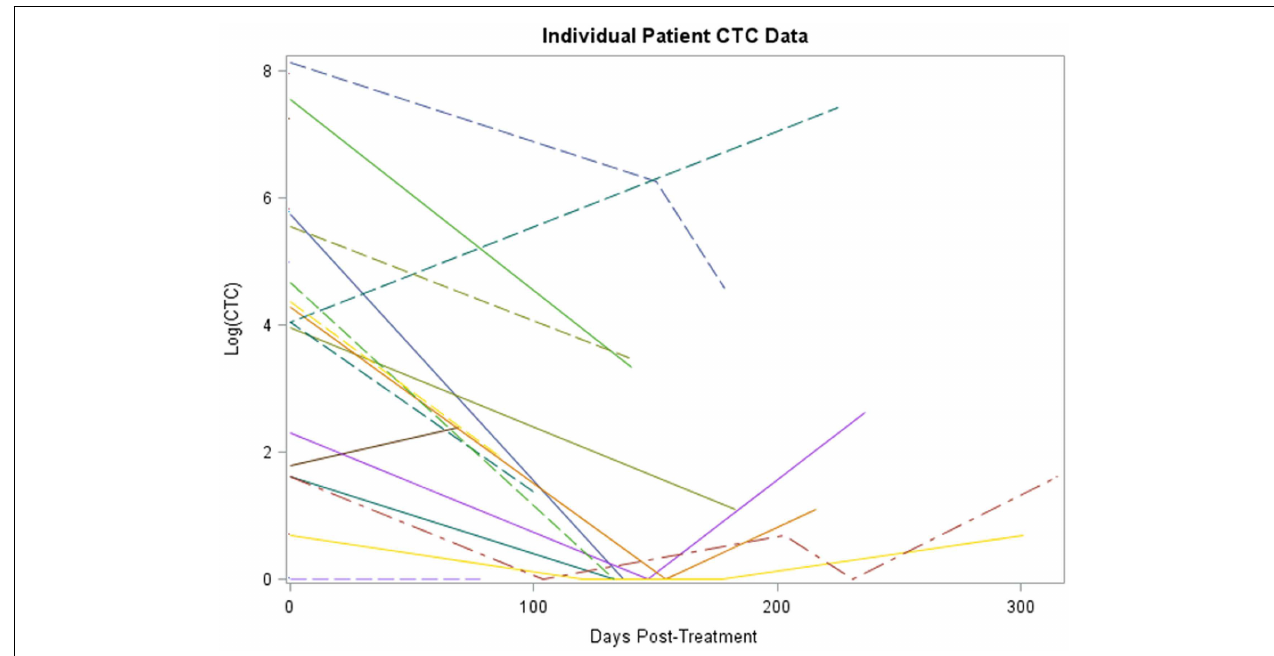
FIGURE 1 | Plot of individual patient-level CTC change data (log scale) .The x -axis is number of days post-treatment at which the CTC measurement was collected for patient, y -axis is the percent change from baseline at that time for each patient, each patient has a line representing his or her change.